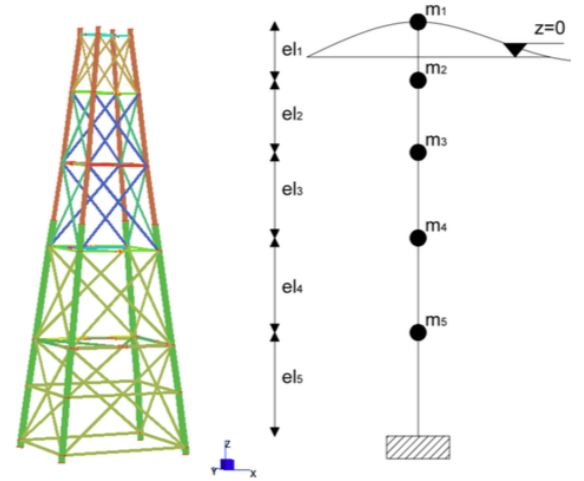
Figure 1. Jacket modeled by Strand7 and